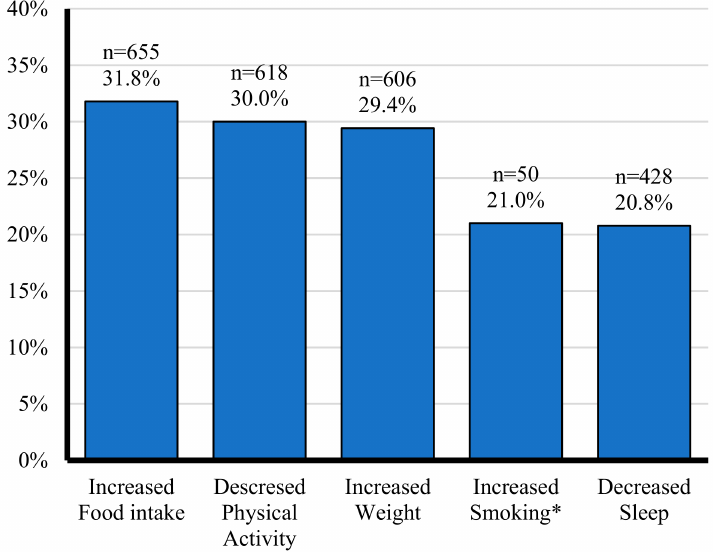
Figure 1. Prevalence of unhealthy lifestyle behaviors among study participants ( n = 2060). * Percent- age among smokers (N =